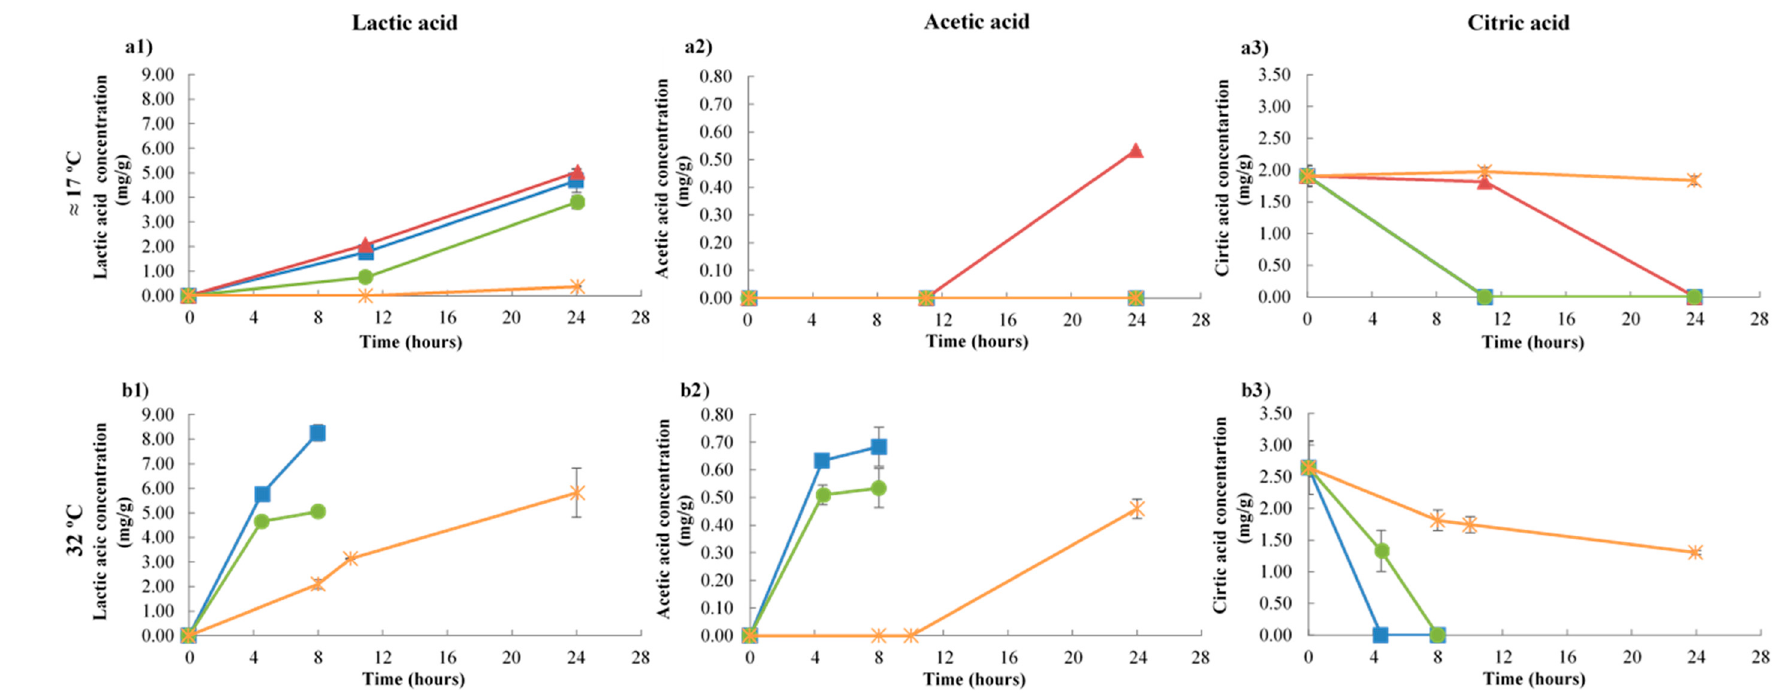
≈ 17 ◦ C ( a ) and 32 ◦ C ( b